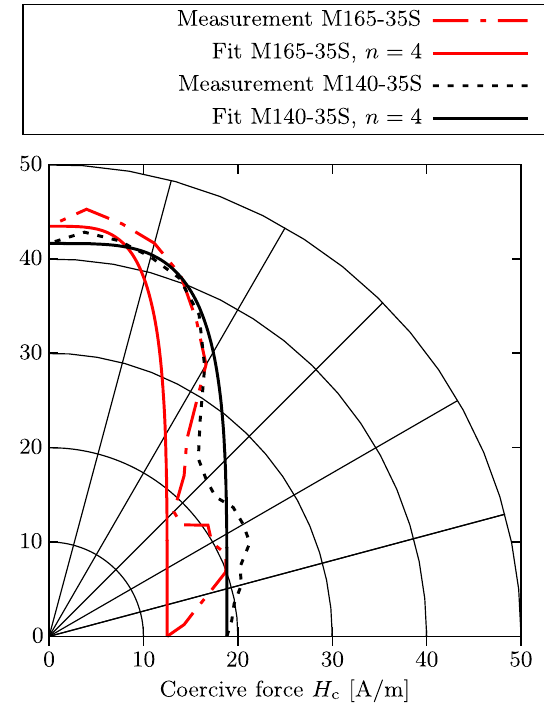
FIG. 19. Measurement and fit of the coercive force versus angle in polar coordinates at J ≈ 1 . 4 T for two GO steel